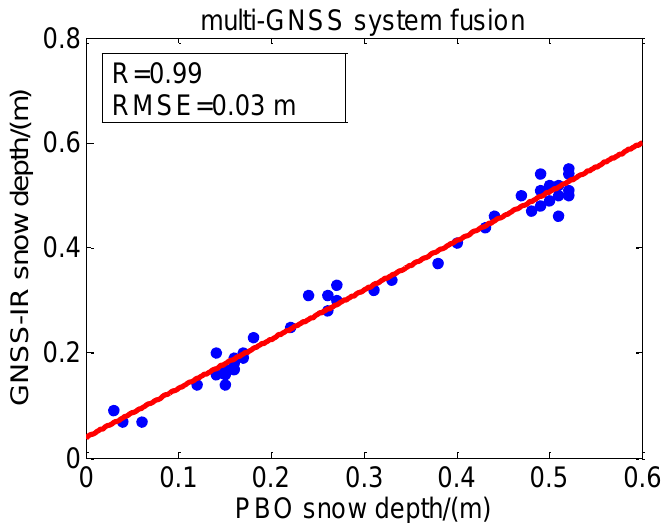
Figure 16. Comparison of the mean fusion results of multi-GNSS system with PBO snow depth.